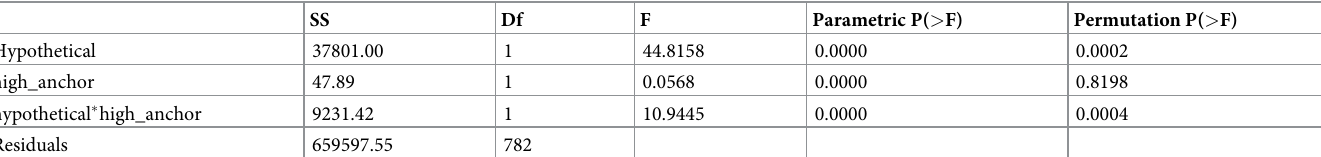
Table 10. Experiment 2: Permutation